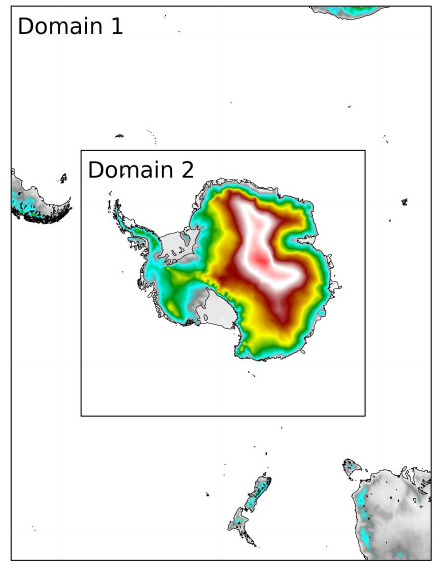
Figure 2. AMPS domains used for model output analysis in this